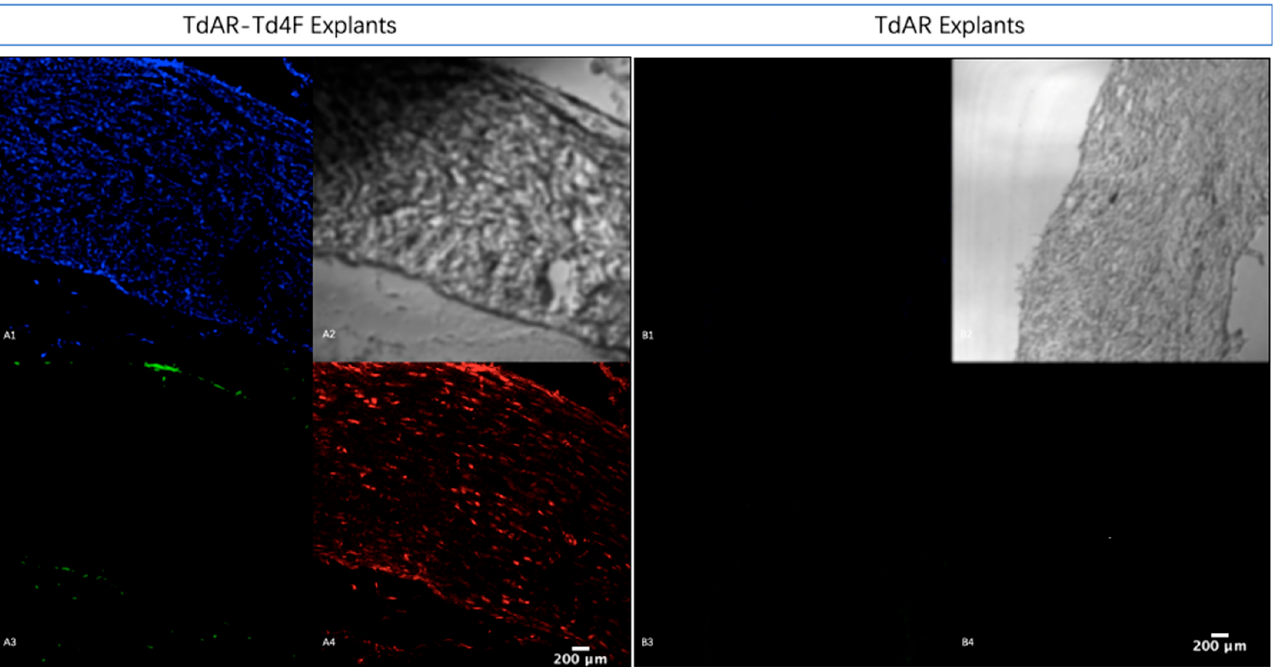
Figure 4. Td4F prolonged the expression of Scx and Col1a1 in explant cultures. For further observa- tion of explants after ten days in in vitro cultures, explants were fixed and sectioned for observation under confocal microscopy. Compared to explants from TdAR mice, Achilles tendon explants from TdAR-Td4F mice were found to remain stably expressed in mScarlet and BFP after Td4F-EmGFP overexpression had ceased. ( A ): Frozen sections of Achilles tendon explants from TdAR-Td4F mice cultured for ten days in vitro under confocal microscopy (×10 magnification). ( B ): Frozen sections of Achilles tendon explants from TdA mice cultured in vitro for ten days under confocal microscopy (×10 magnification); 1 – 4 show observations of Col1a1-BFP ( A1 , B1 ), brightfield ( A2 , B2 ), Td4F- EmGFP ( A3 , B3 ) and Scx-mScarlet ( A4 , B4 ) under confocal microscopy, respectively (×10 magnifica- tion).